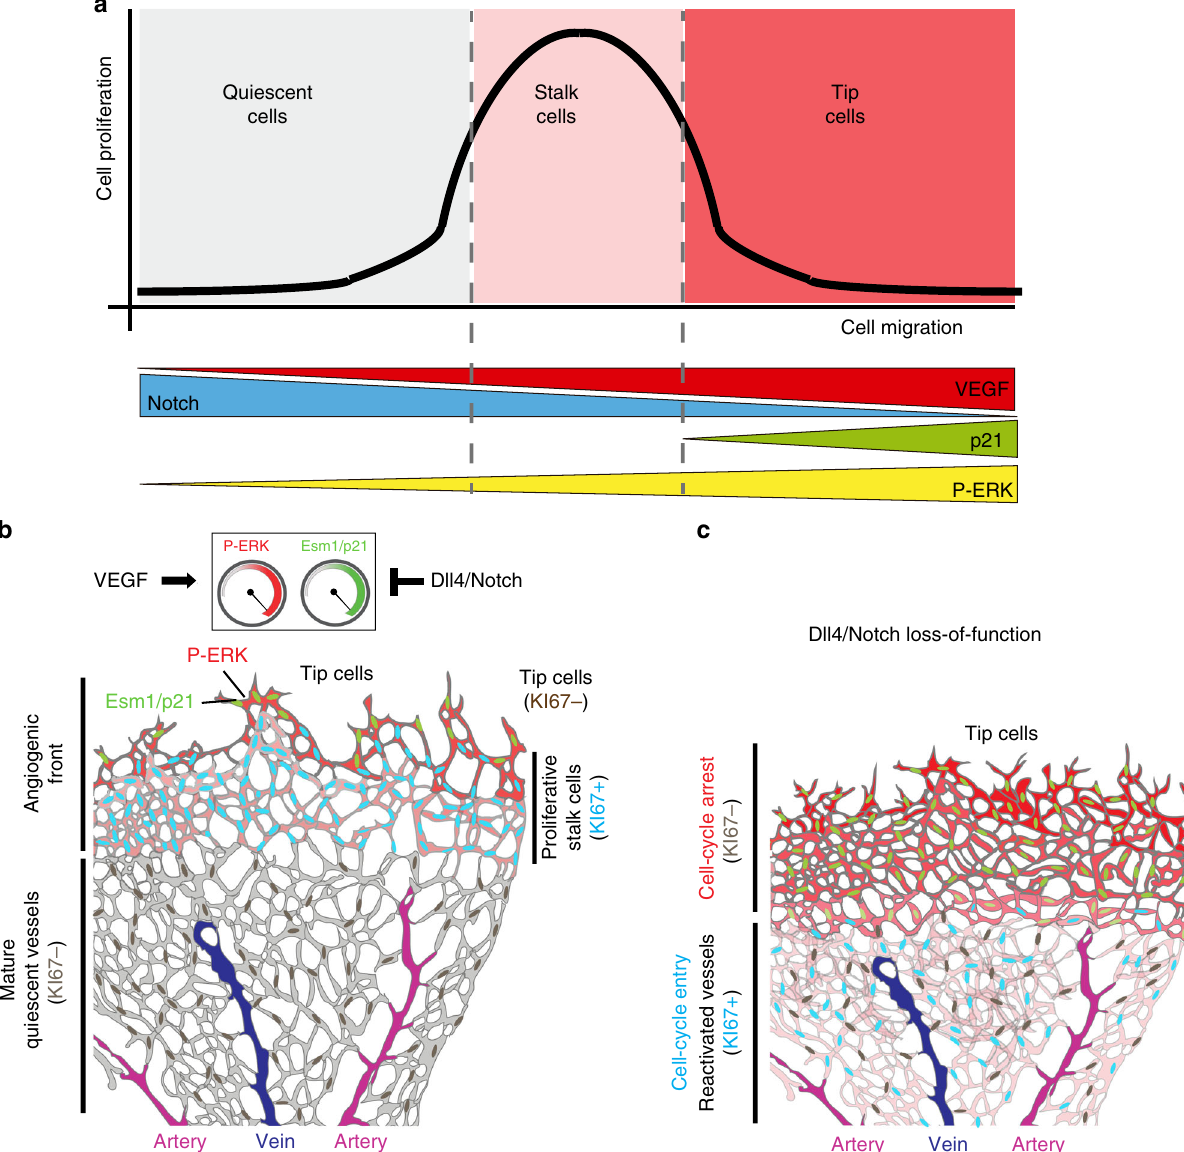
Fig. 8 High-mitogenic stimulation arrests angiogenesis. a Proposed bell-shaped dose – response to mitogenic stimulation regulated by Notch, VEGF, ERK, and p21. At very low levels of VEGF signalling, ECs are quiescent, since they have Notch signalling, which supresses ERK activity and cell proliferation. Stalk cells have a properly balanced level of Notch and VEGF signalling, resulting in an ERK activity level ideal for cell proliferation. Tip cells have high-VEGF signalling, and low-Notch signalling, resulting in cumulative high ERK activity, which induces p21, cell-cycle arrest, and cell sprouting/migration. b Illustration showing the identi fi ed distribution of the indicated cellular markers in tip, stalk and quiescent ECs. Colours indicate P-ERK (red cytoplasm), Esm1/p21 (green nuclei), KI67 (blue if positive and dark grey if negative). Colour intensity indicates the observed strength of signal or expression. At the angiogenic front, endothelial tip cells receive a higher mitogenic stimulus from VEGF. This induces ERK activation and high expression of Esm1 and p21. Higher Notch signalling in stalk cells attenuates the VEGF-induced ERK and p21 activation. In the more mature and quiescent vascular areas, most ECs have very low P-ERK levels and have already exited the cell cycle (KI67 − ) because they are exposed to less VEGF. However, these cells still have active Notch signalling, which is important for maintaining their quiescence. c When Dll4/Notch signalling is inhibited, angiogenic stalk cells display a tip-cell like pro fi le and upregulate Esm1 expression and ERK phosphorylation. This leads to p21 expression, which induces the cell-cycle arrest of stalk-cells, and compromises the subsequent proliferation and development of vessels toward the hypoxic tissue area. Impairment of Dll4/Notch signalling in more mature and quiescent ECs (grey), produces a distinct effect; here, the increase in P-ERK after Dll4/Notch inhibition is more moderate and productive, and ECs enter the cell cycle even when VEGF signalling is